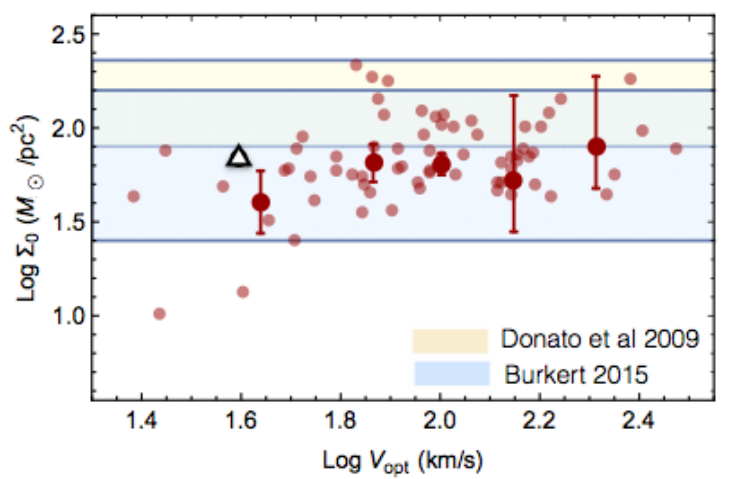
Figure 15. ( up ): central DM halo density vs. core radius. Legend explains the details. ( bottom ): central surface density Σ 0 = ρ 0 r 0 vs. optical velocity V opt (red points). Additionally shown the relation in [160] (yellow shadowed area) and in [234] (light blue shadowed area). Dwarf discs data from [30]. Image reproduced from